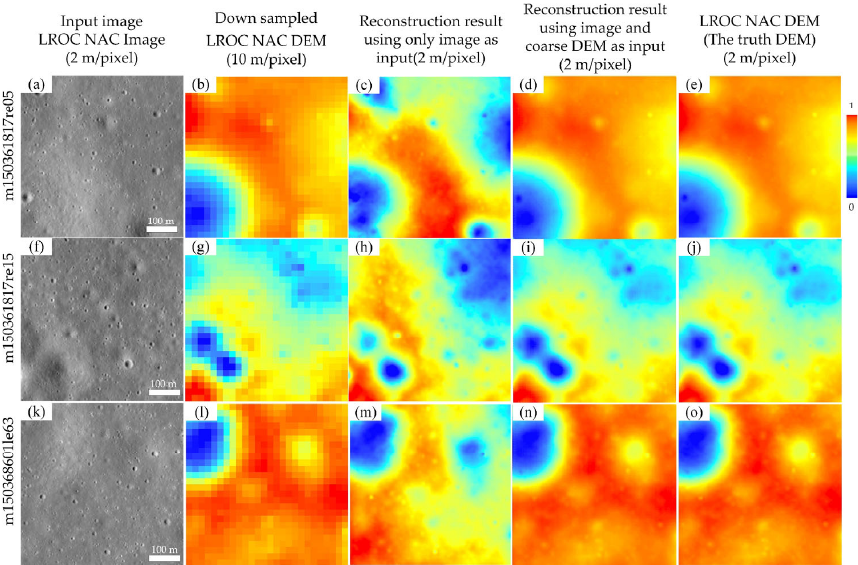
Figure 7. Comparisons of image reconstruction results with and without the help of coarse DEM. Each row shows results of one area. Column 1: The input image of LROC NAC image of 2 m/pixel. Column 2: The coarse DEM obtained by downsampling LROC NAC DEM from 2 m/pixel to 10 m/pixel. Column 3: The reconstructed result taking only image as input. Column 4: The recon ‐ structed result using both image and coarse DEM as input. Column 5: The ground truth DEM of LROC NAC DEM (2 m/pixel).